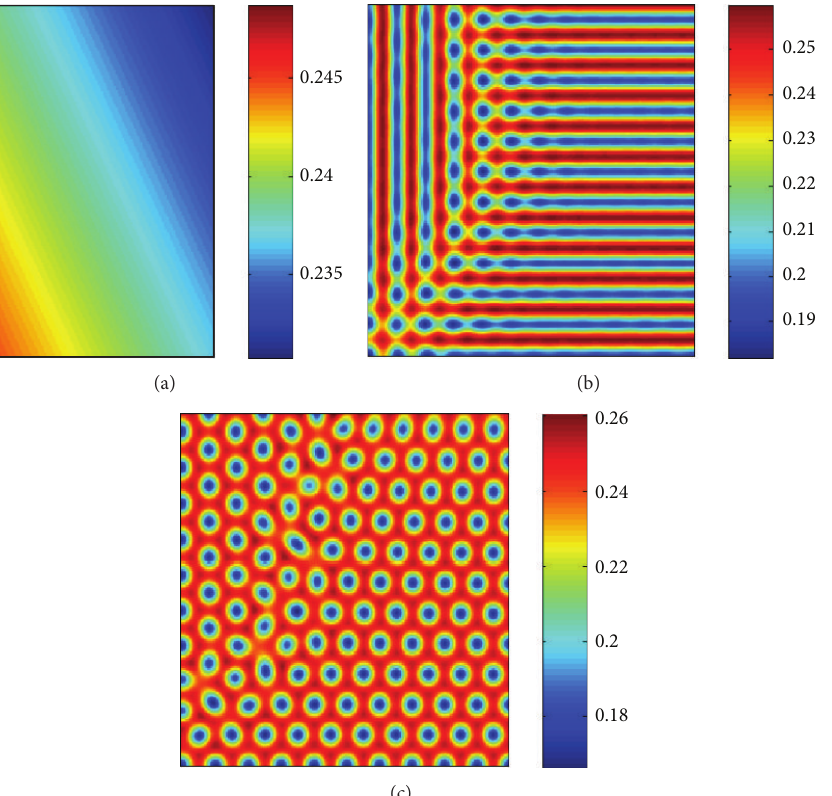
Figure 13: Snapshots of contour pictures of the time evolution of predator in system (3) with the initial condition (30) when 𝑑 2 = 7 and 𝛿 = 0.6 : (a) 0 iteration, (b) 100000 iterations, and (c) 1000000